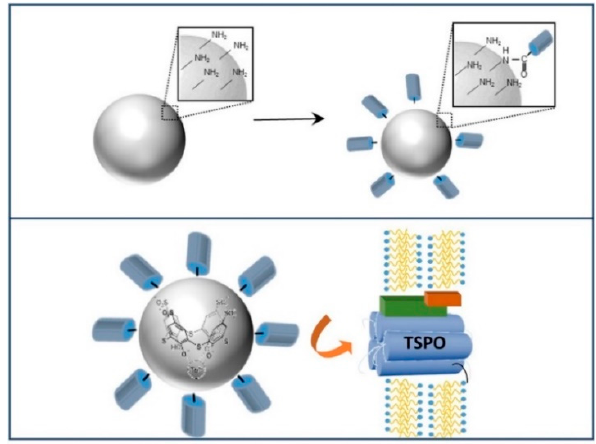
Figure 2. Sketches of the conjugation reaction of amino functionalized SNs with TSPO ligand (upper panel) and the translocator protein (TSPO) ligand functionalized silica